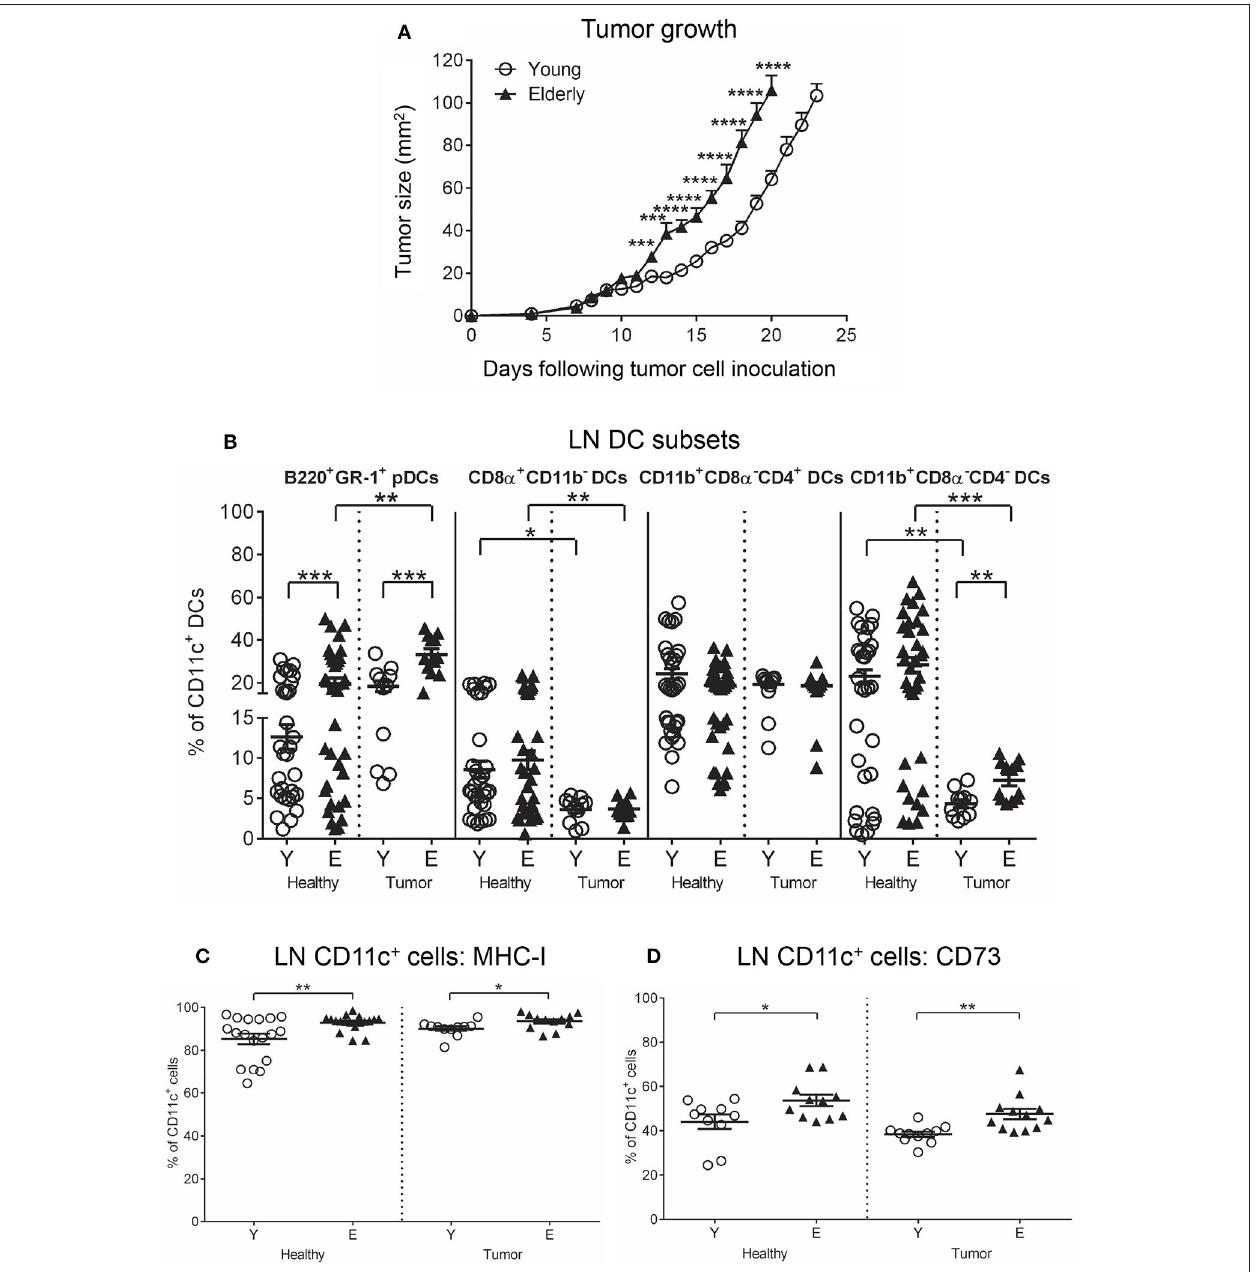
FIGURE 1 | AE17 mesothelioma tumors grow faster in elderly mice. Young ( n = 13) and elderly ( n = 15) mice were inoculated subcutaneously with 5 × 10 5 AE17 tumor cells per mouse, and tumor size (mm 2 ) measured daily (A) ; data shown as mean ± SEM. At end point, TDLNs from the same tumor-bearing mice and LNs from age-matched healthy mice ( n = 32 young and 35 elderly mice) were analyzed for DC subsets (B) , MHC-I + CD11c + cells (C) and CD73 + CD11c + cells (D) using flow cytometry. Data are shown for individual mice as well as mean ± SEM. Mouse numbers for B-D differed on account of varying cell numbers available for analysis and ranged from n = 11–13 young and n = 12–15 elderly tumor-bearing mice, n = 10–32 young and n = 11–35 elderly healthy mice, * p < 0.05, ** p < 0.005, *** p < 0.0005, **** p < 0.0001 comparing (i) young to elderly mice, or (ii) tumor-bearing mice to age-matched healthy mice.